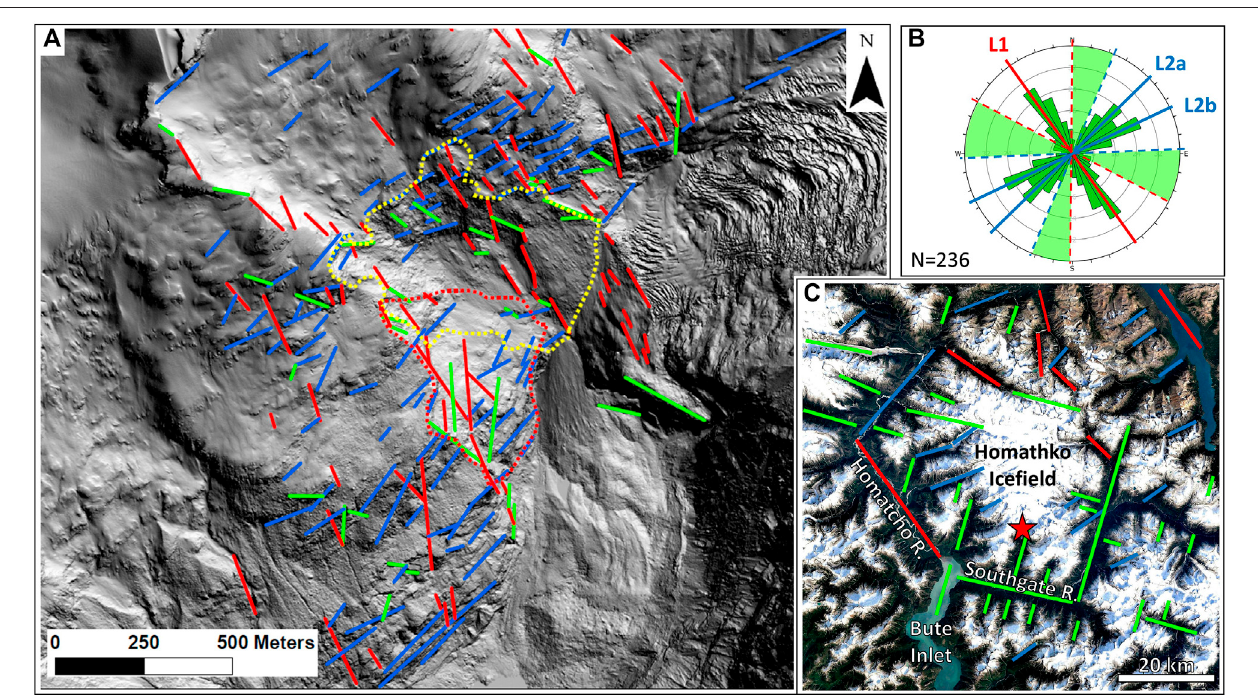
FIGURE 6 | Lineament analysis summary. (A) lineament map of the slope affected by the 2020 landslide, overlayed on the post-failure hillshade map. Mapped lineaments are color-coded based on the trend shown in (B) . (B) Rosette diagram showing the trends of the major observed lineaments. Green zones in the diagram identify the lineaments that cannot be ascribed to a speci fi c trend (green lines in (A,C) . (C) Regional map showing the similarity between lineament trends and geomorphic features (e.g., river valleys). Red star indicates the location of the landslide area towards the head of Elliot Creek.